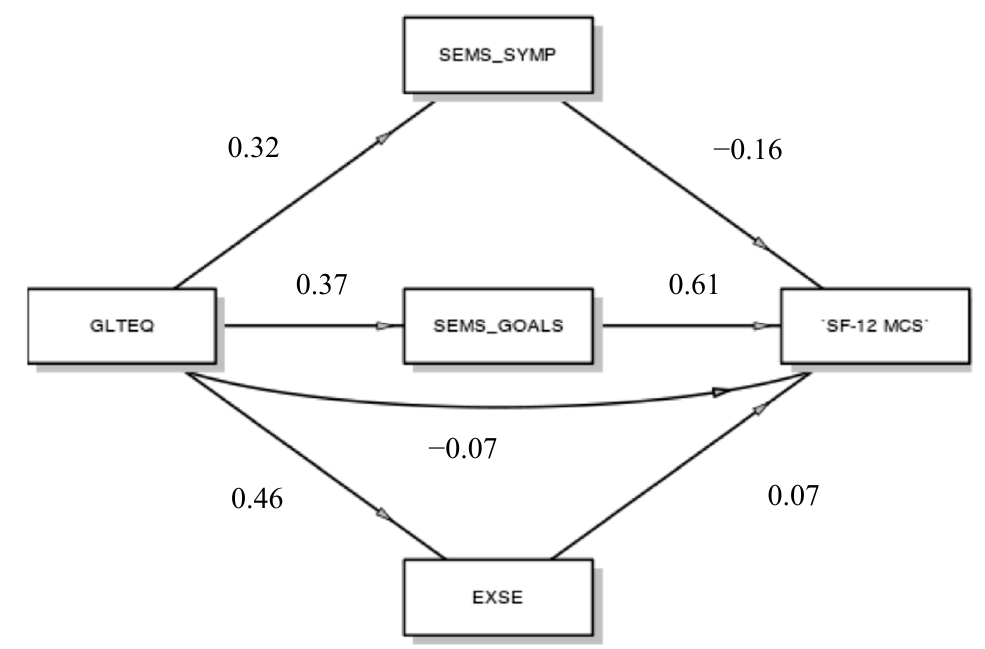
Figure 1. Mediation model. GLTEQ, Godin Leisure-Time Exercise Questionnaire; SEMS_SYMP, Self-Efficacy for Multiple Sclerosis Subscale Symptom Management; SEMS_GOALS, Self-Efficacy for Multiple Sclerosis Subscale Goal setting; EXSE, Exercise Self-Efficacy, SF-12 MCS, SF-12 Health Survey Subscale Mental Component Summary.